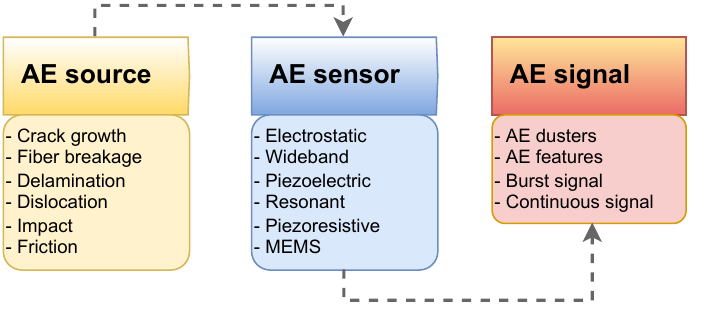
Figure 16. AE sensor bridging AE source and AE signal in a simple acoustic emission sensing